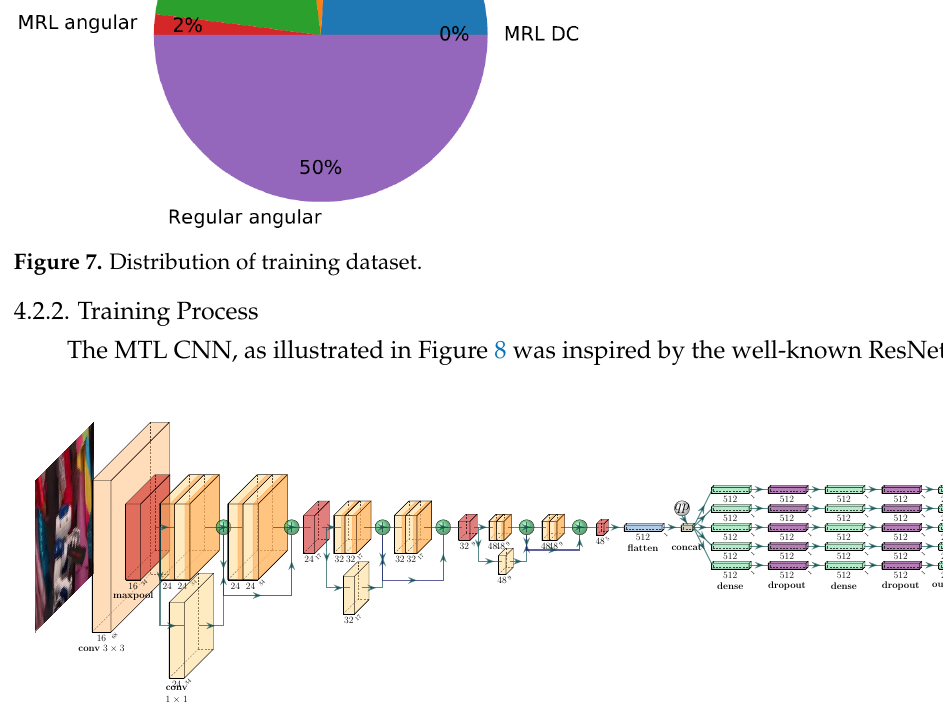
Figure 8. The MTL CNN architecture. Convolution layers are in orange and yellow, max-pooling layers in red, dropout in purple, and fully connected layers in